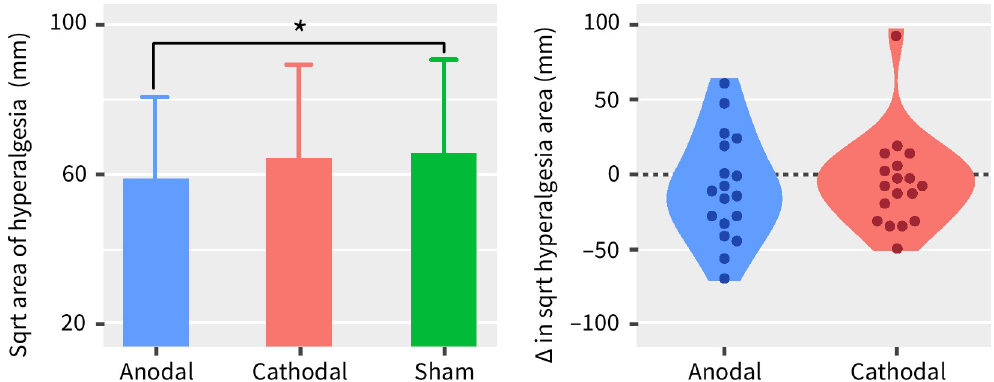
Fig 5. Left: Comparison of the estimated marginal means of the extent of the hyperalgesia area after anodal, cathodal, or sham multifocal tDCS over the left DLPFC, averaged across timepoints, and expressed as the square root of the area of increased pinprick sensitivity (mm). Data are presented as mean and 95% confidence interval. The asterisk indicates the significant difference between anodal and sham tDCS (Tukey HSD test, p = 0.02). Right: Differences in the area of hyperalgesia between sham and anodal or cathodal multifocal tDCS over the left DLPFC, averaged across time-points. Subject-level differences (anodal minus sham or cathodal minus sham) are represented by the dots. Negative values represent a smaller area of hyperalgesia for anodal or cathodal when compared to